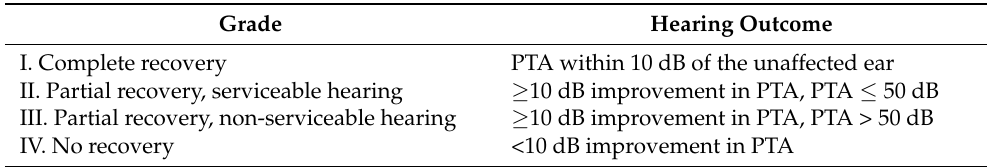
Table 1. Grading system according to the pure-tone average, which was modified from the American Academy of Otolaryngology-Head and Neck surgery